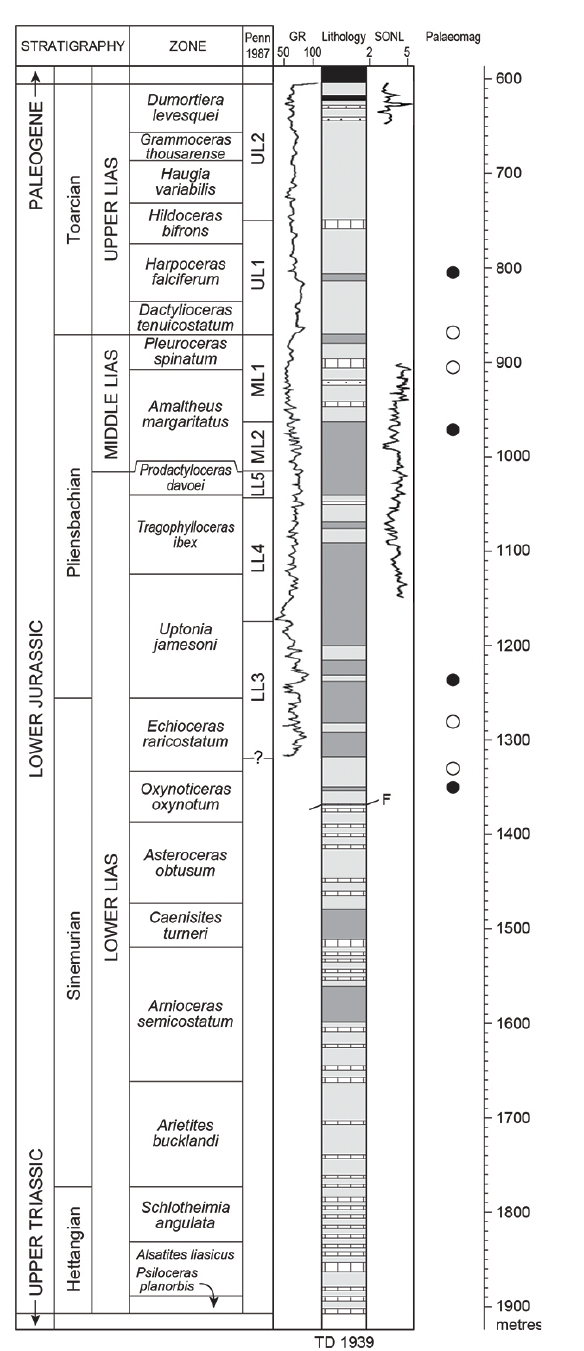
Figure 3. Summary stratigraphy for the first Mochras borehole showing complete representation of Early Jurassic ammonite zones (modified from Tappin et al., 1994). Also indicated are the palaeo- magnetic polarities from pilot studies of MacNiocaill and Robin- son (unpublished data). Lithology: black – conglomerate, grey – silt / mudstone, light grey mudstone, dots – sandstone, bricks, lime- stone, TD – terminal depth, F – fault, GR – gamma-ray log, SONL – sonic log, black dot – normal polarity, white dot – reversed